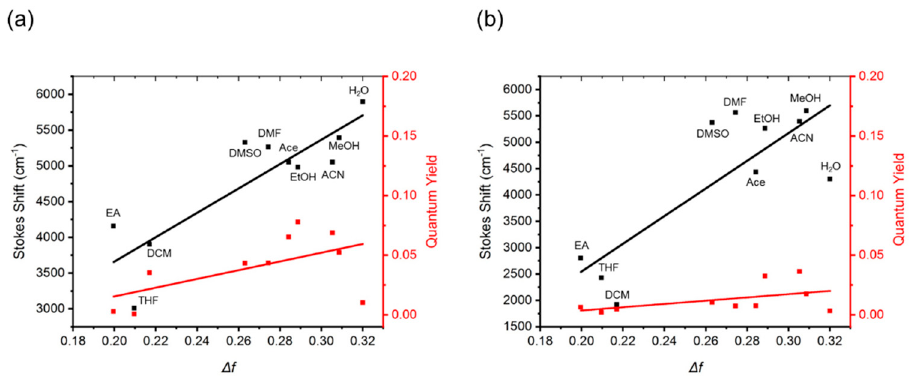
Figure 3. The Lippert–Mataga plots and the corresponding quantum yields of MeAcd12C ( a ) and MeAcd12P ( b ). The values of the Stokes shifts were calculated from the observed maxima present in the absorption and emission spectra, respectively. Values of the quantum yields were determined by a comparative method.